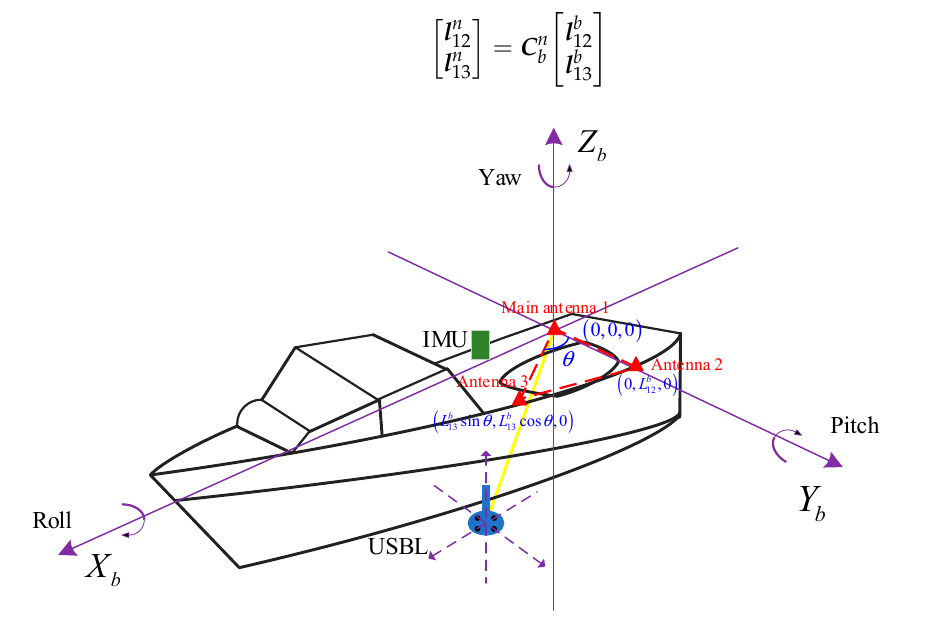
Figure 3. Three-antenna installation diagram.